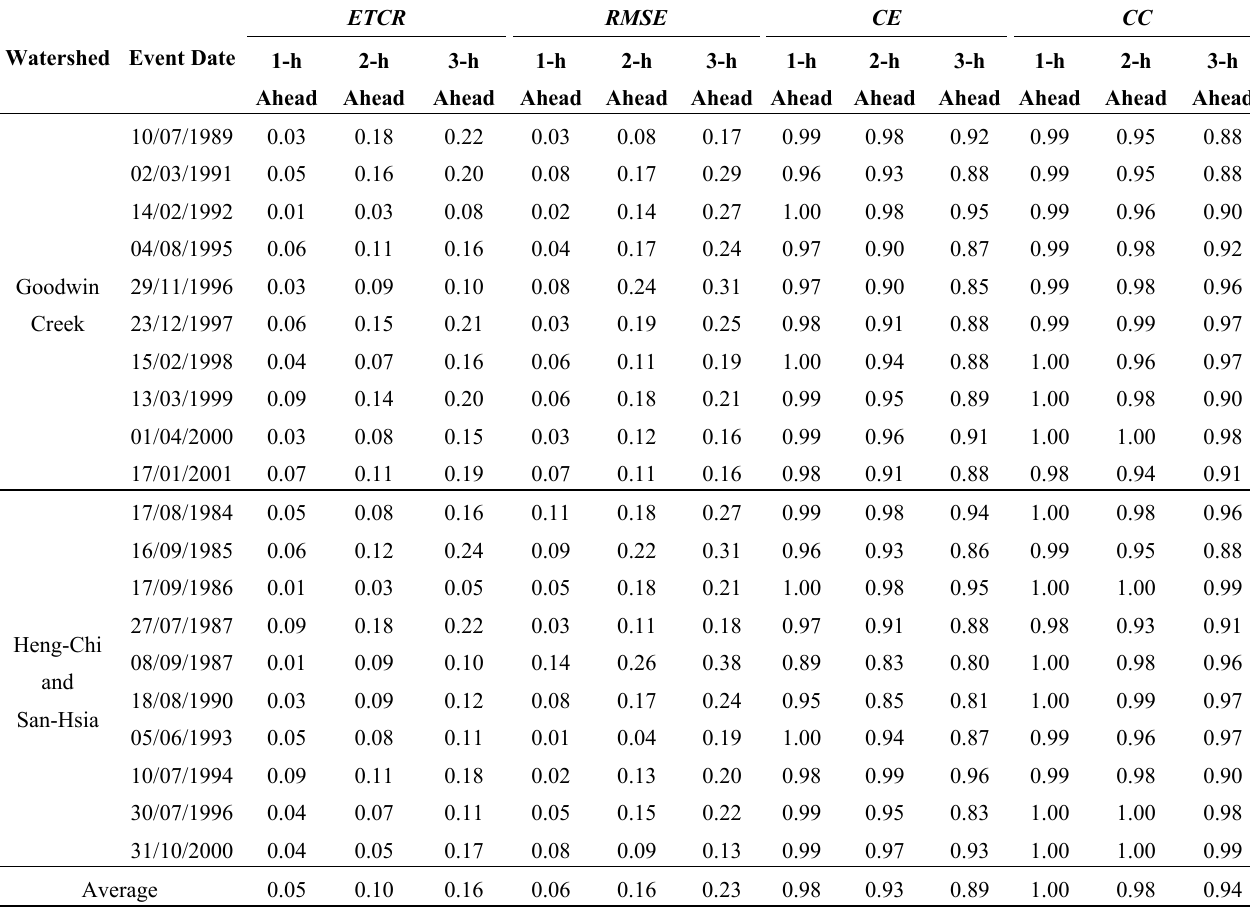
Table 3. Results of grey forecast